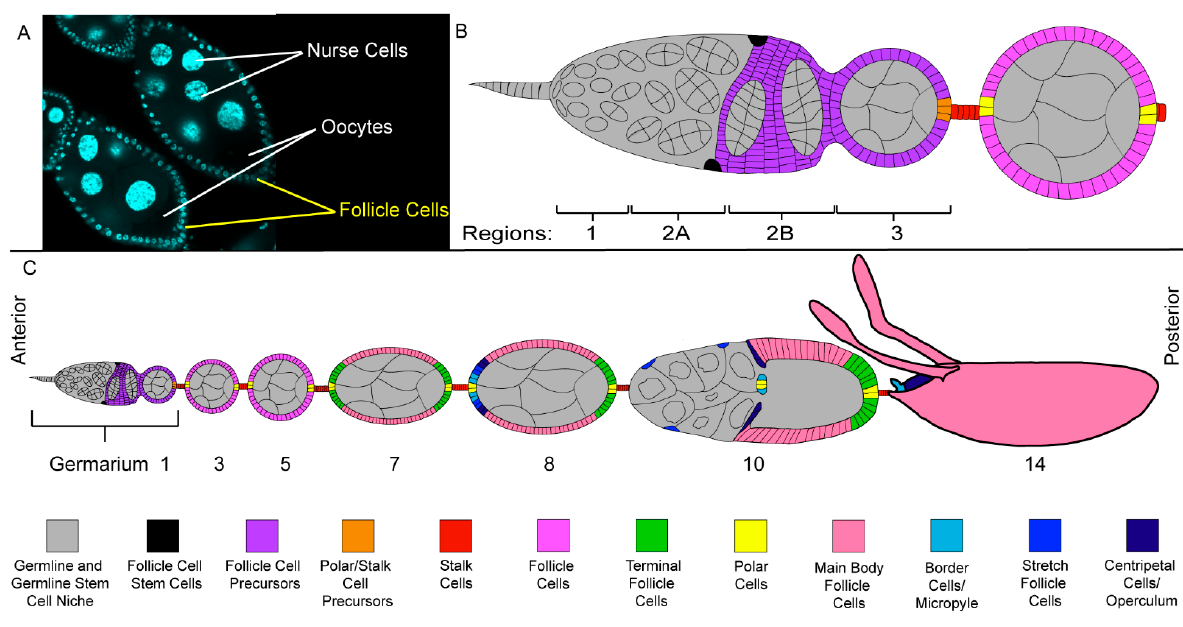
Figure 2. Somatic Cells of the Drosophila ovary ( A ) DAPI-stained egg chambers containing 15 NCs and a single oocyte. This syncytium of 16 cells is surrounded by a layer of smaller epithelial FCs. ( B ) A detailed schematic of an ovariole with the somatic cells in color and the germline cells, stem cells, and niche in grey (see color scheme in Figure 2C). The FCs are produced by the follicle cell stem cells found in region 2A of the germarium. ( C ) A detailed schematic of an ovariole with somatic cells in color and the germline cells, stem cells, and niche in grey.